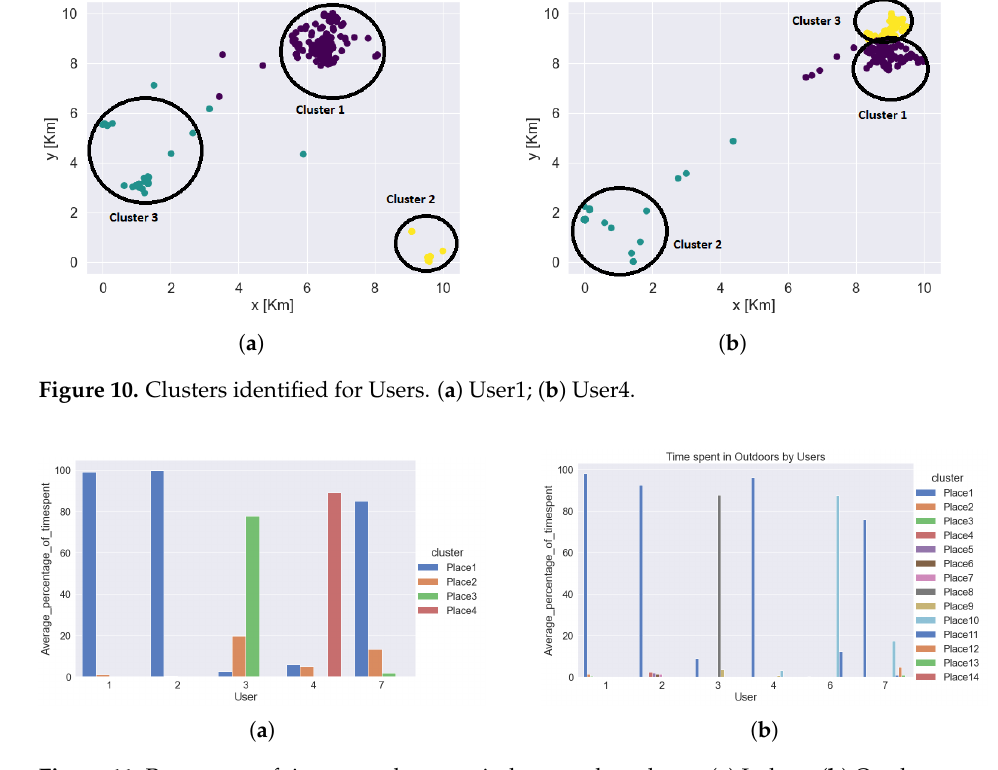
Figure 11. Percentage of time spent by users indoors and outdoors. ( a ) Indoor; ( b )